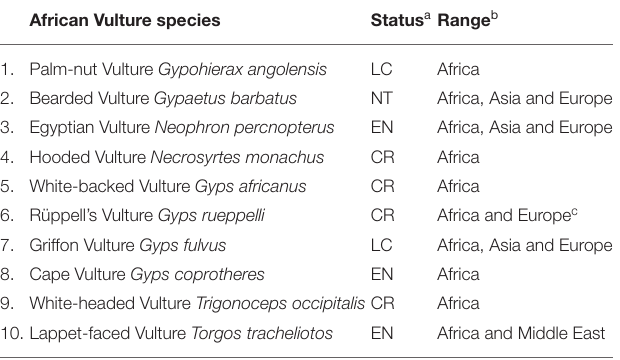
TABLE 2 | Status and range of the 10 vulture species commonly found in Africa. African Vulture